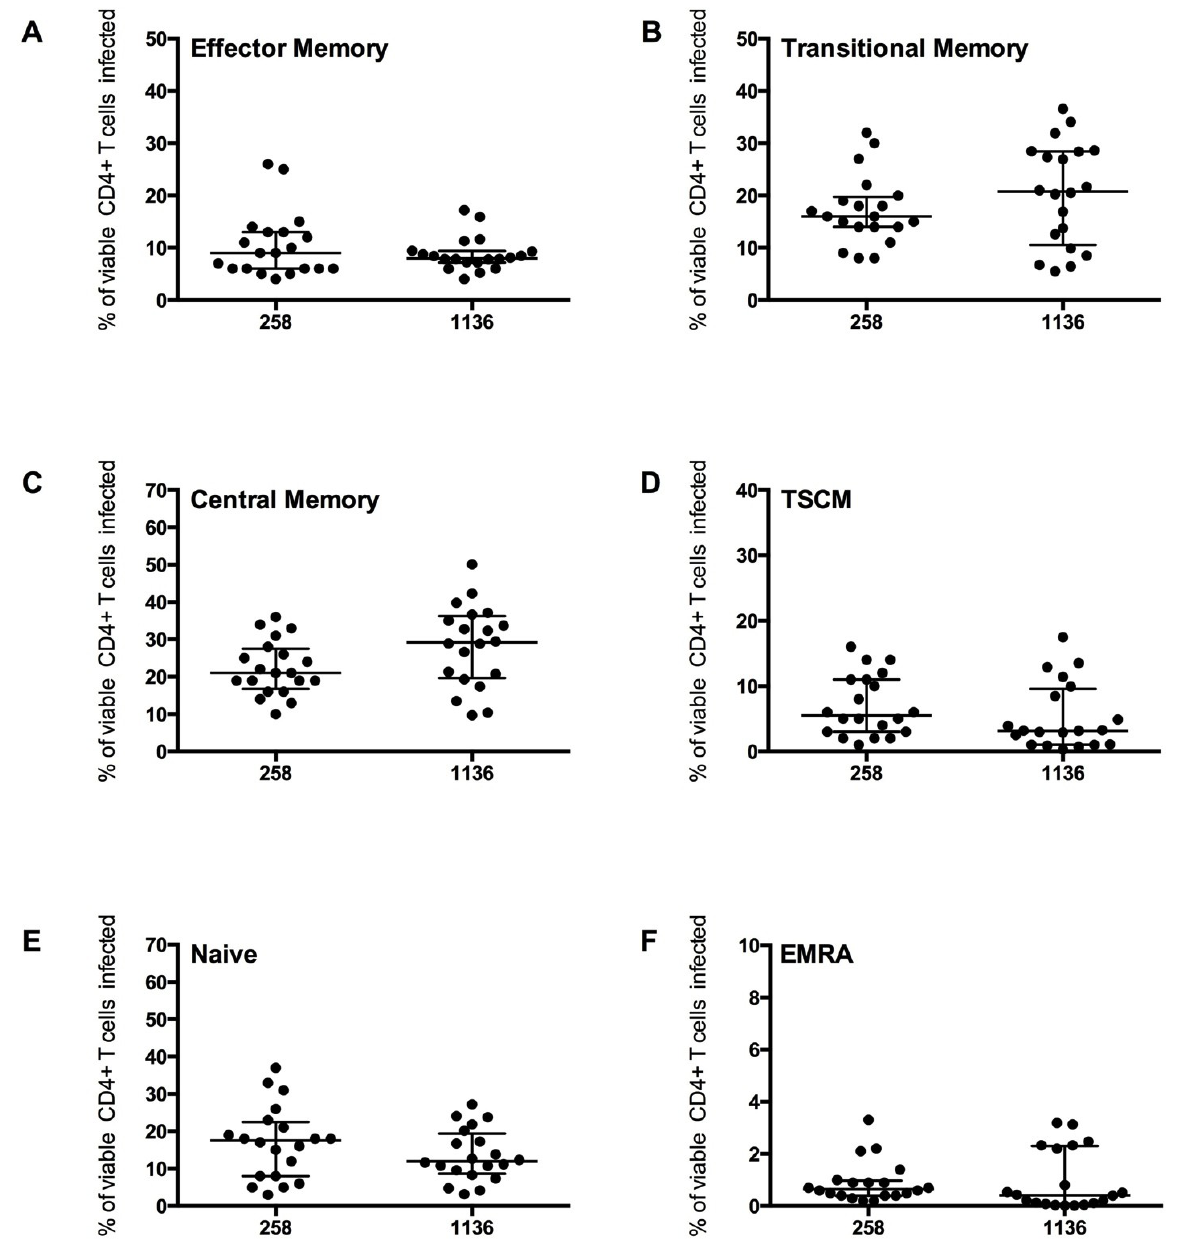
Figure 6. CD4 + T cell subset infection by HIV-1 subtype C Env pseudotyped GFP reporter viruses. CD4 + T cells from 5 healthy donors were infected with virus pseudotyped with